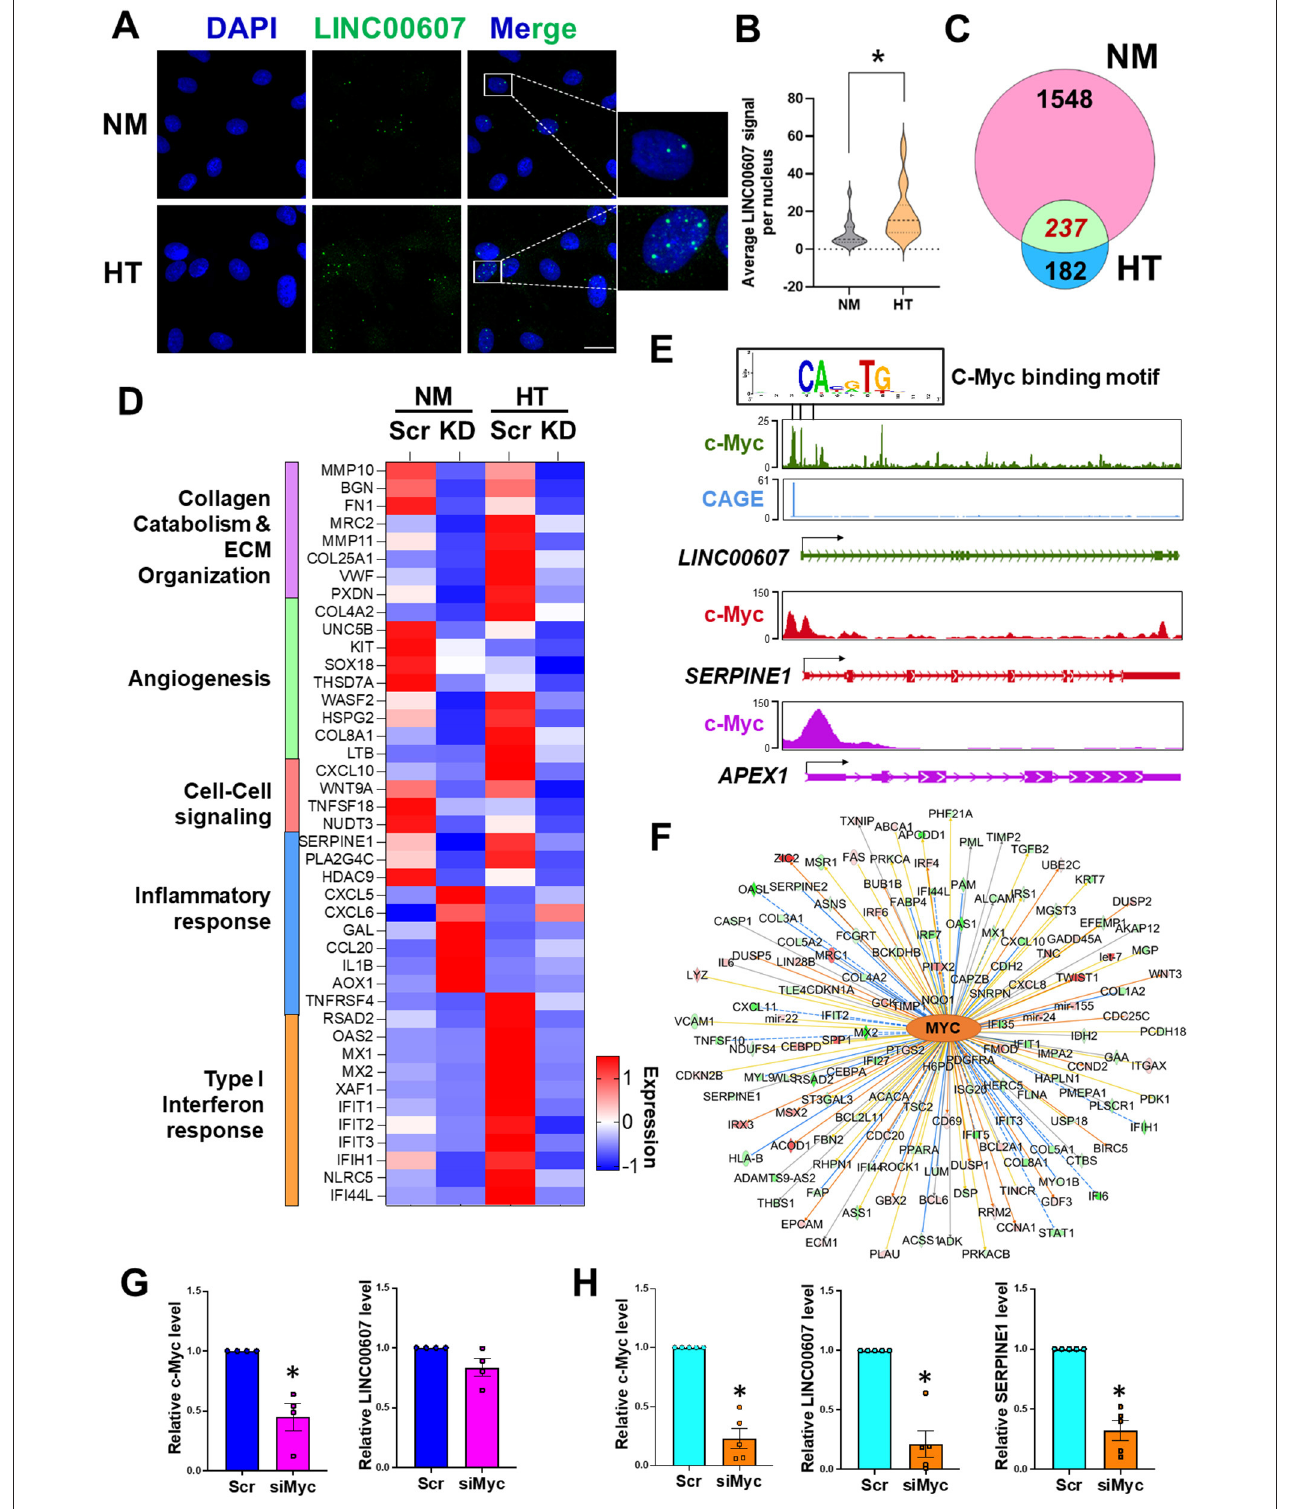
FIGURE 3 | Stimulus-dependent regulatory function of LINC00607 in ECs. (A) Representative images of smFISH detecting LINC00607 (green) in HUVEC treated with normal glucose (5.5mM D-glucose) and osmolarity control (NM) or 25mM D-glucose and 5ng/ml TNF α (HT) for 3 days. DAPI staining indicates the nuclei. Scale bar = 20 µ m. (B) Quantitative data of LINC00607 signal per nucleus. LINC00607 signal from 18 nuclei for NM and 24 nuclei for HT was quantified using ImageJ. (C) Venn